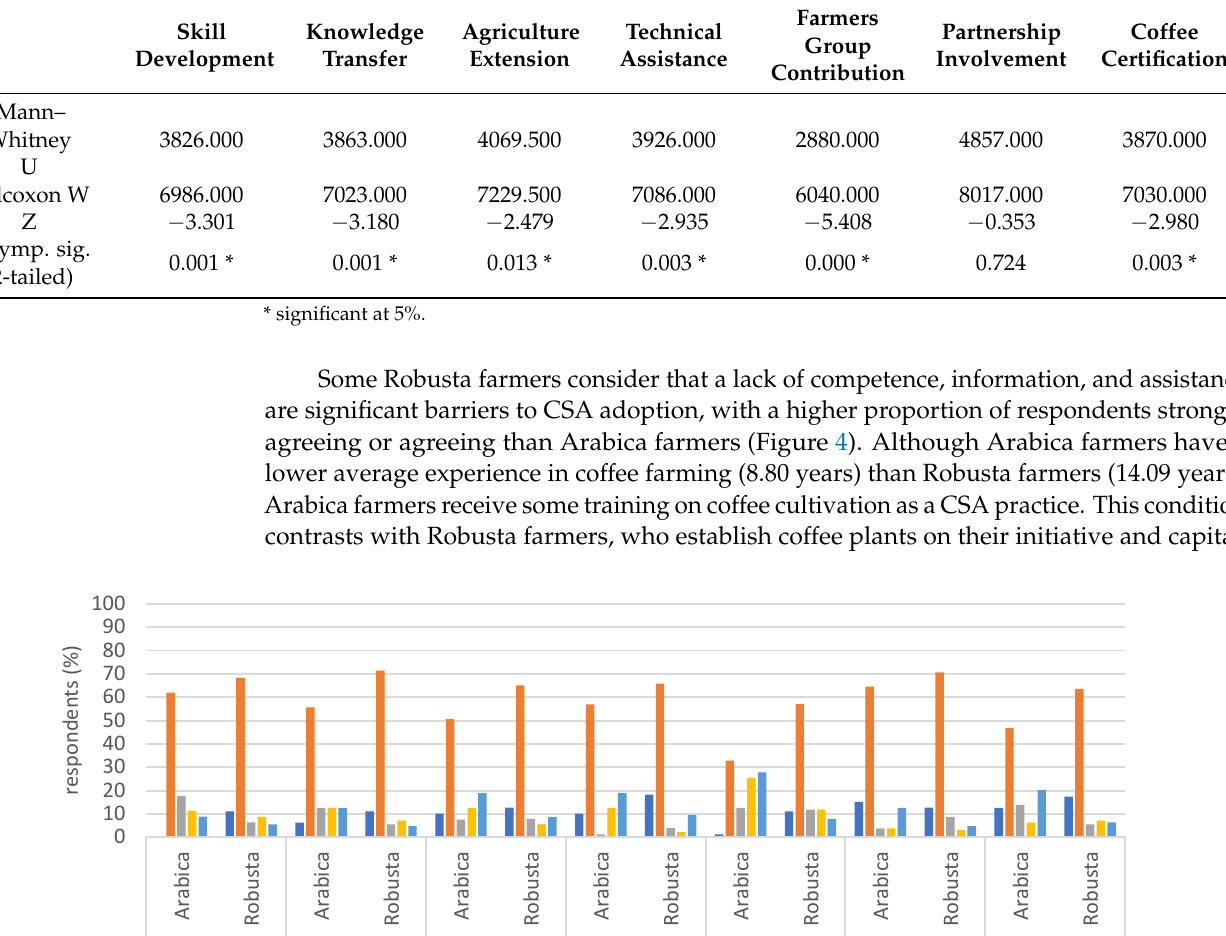
Table 7. Process barriers to implementing CSA practices.